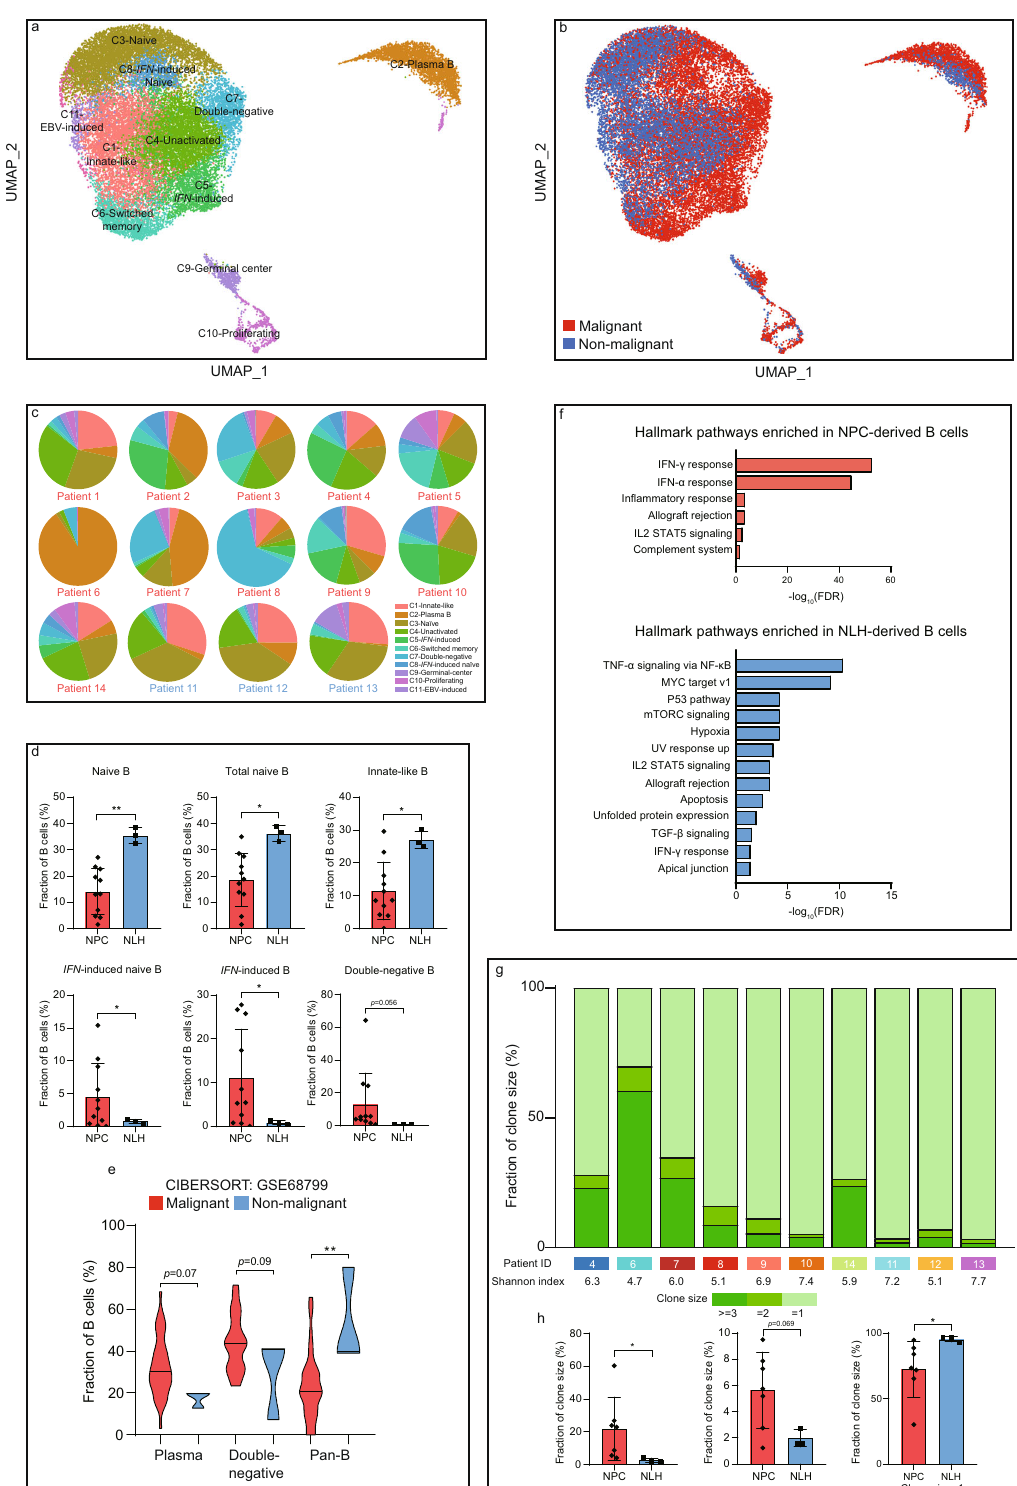
Hallmark pathways enriched in NPC-derived B cells ComplementsystemIL2STAT5signalingAllograftrejectionInflammatoryresponseIFN-αresponseIFN-γresponse -log 10 Hallmark pathways enriched in NLH-derived B cells 15ApicaljunctionIFN-γresponseTGF-βsignalingUnfoldedproteinexpressionApoptosisAllograftrejectionIL2STAT5signalingUVresponseupHypoxiamTORCsignalingP53pathwayMYCtargetv1TNF-αsignalingviaNF-κB -log 10 (FDR)